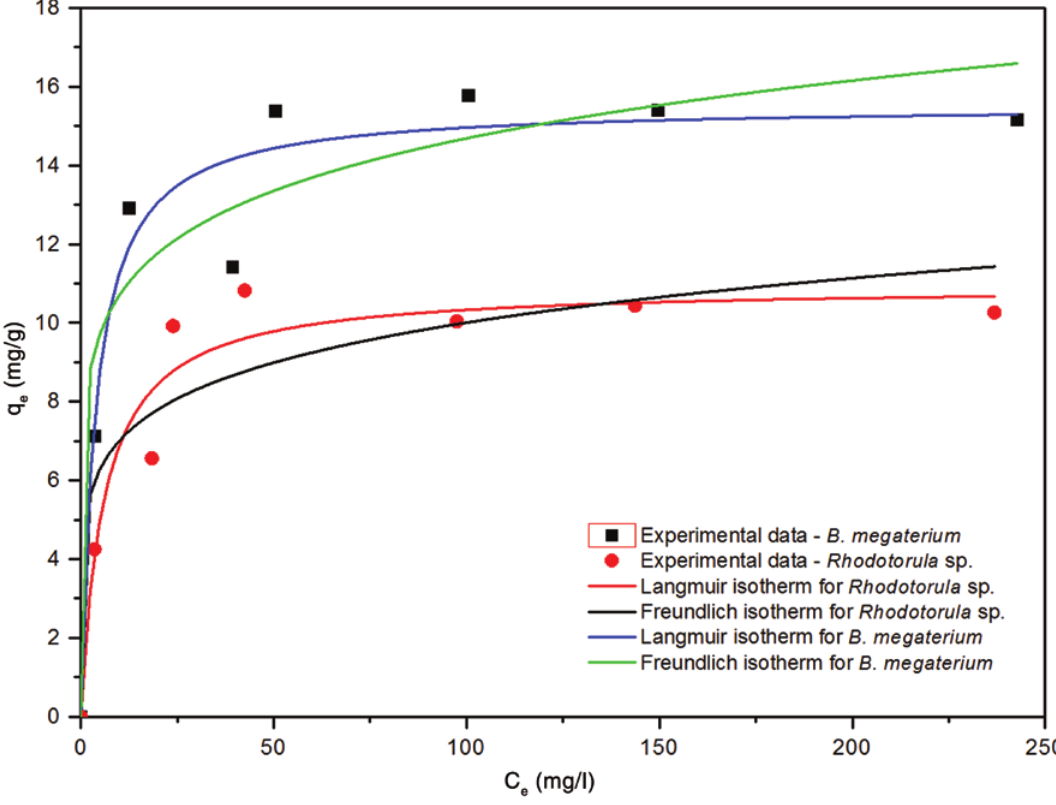
Figure 5: Influence of initial concentration on biosorption of Cd(II) ions by Rhodotorula sp. (pH 6, biomass dosage 5 g/l, contact time 48 h, temperature 25 ° C) and B. megaterium (pH 4, biomass dosage 3 g/l, contact time 2 h, temperature 25 ° C); Langmuir and Freundlich isotherms modeling.